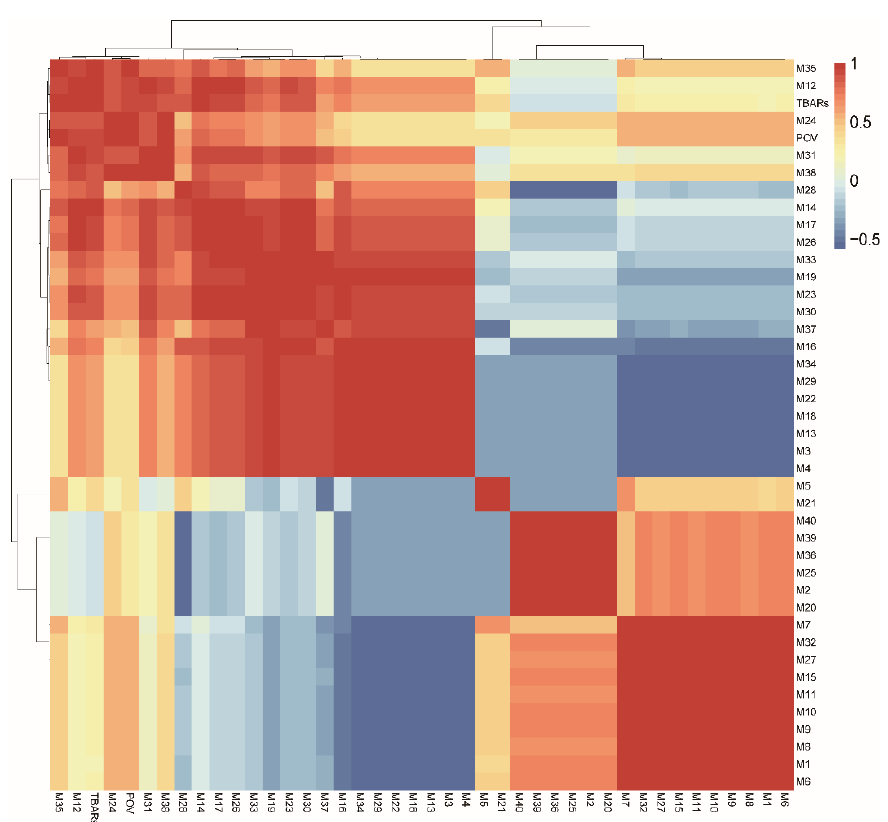
Figure 5. Correlations among POV, TBARS and GC–MS from different stages. The color from blue to red represents a correlation from negative to positive. Fresh: raw sample; YZ: cured sample; XZ: smoking sample; CP: finished sample; POV: peroxide value; TBARS: thiobarbituric acid reactive substance.